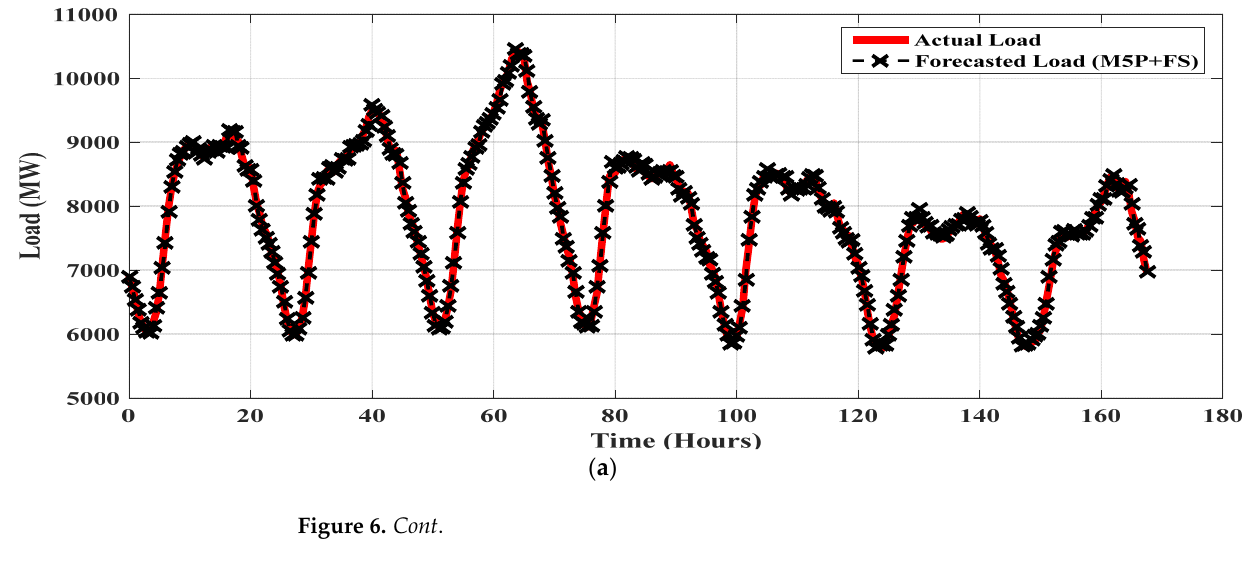
Figure 5. Forecasting in spring 1–7 September 2015 with M5P + FS, ( a ) entire week, ( b – h ) daily forecast.